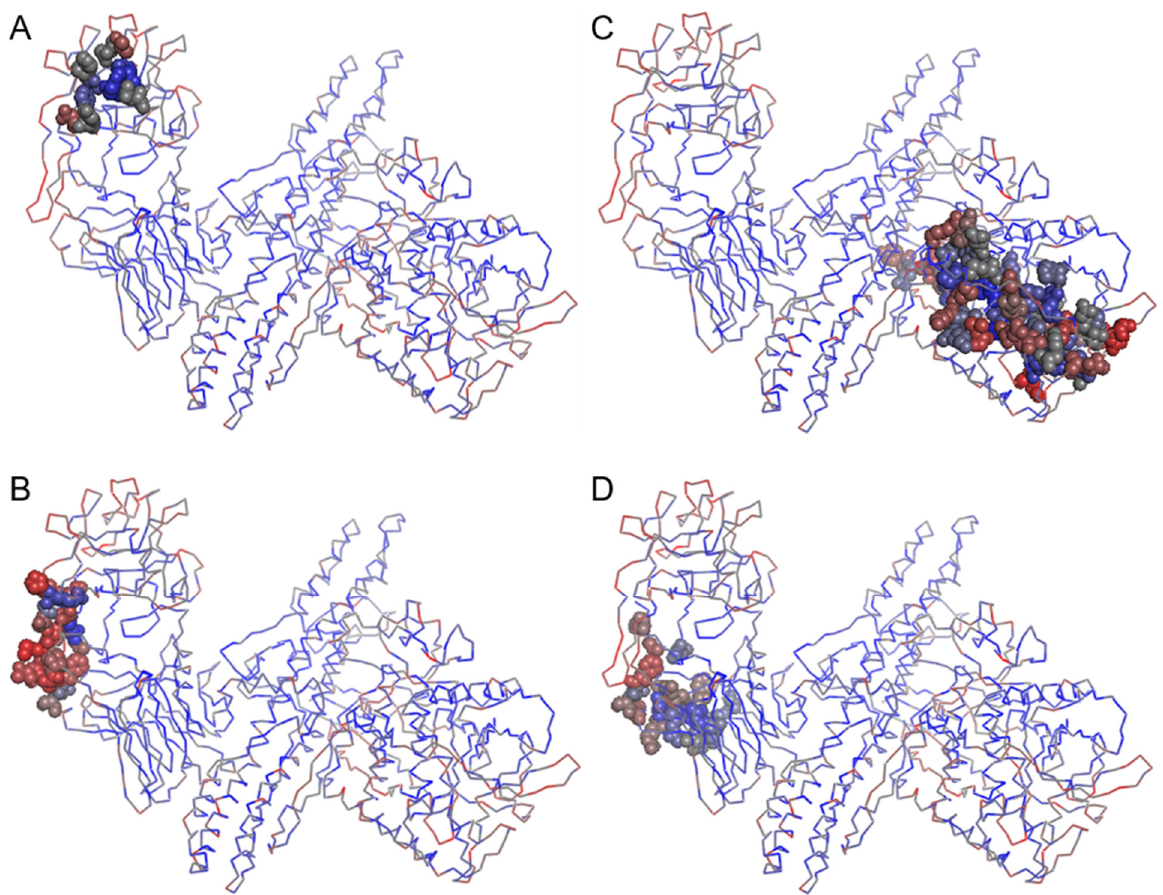
Figure 4. Three-dimensional structure of BoNT protein and the interacting sites with ( A ) ganglioside, ( B ) SV2, ( C ) SNAP-25 substrate and ( D ) monoclonal antibody CR1 against BoNT toxin. The diversity index of each position were mapped onto the 3D structure indicted by the color (from blue to grey to red, low to medium to high). The interacting amino acids were highlighted as spheres with color indicating the diversity index.